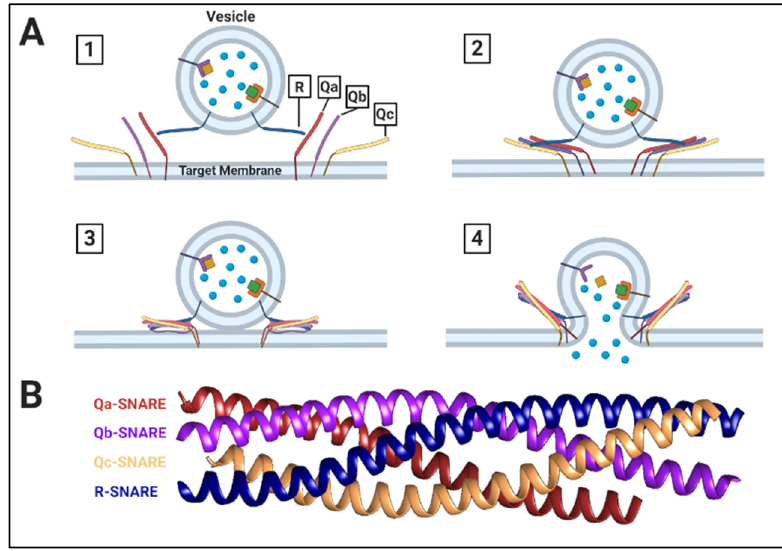
Figure 2. Overview of SNARE Function. ( A ) (1) Cargo-carrying vesicle with R-SNARE reaches the target membrane, which contains associated Q-SNAREs (not pictured: Rab proteins and other associated tethering factors). (2) The vesicle R-SNARE interacts with 3 target membrane Q-SNAREs to initiate SNAREpin complex formation. (3) The SNAREpin forms a “coiled-coil” quad complex, zippering the vesicle and target membrane bilayers into contact. (4) Membrane fusion occurs, releasing soluble cargo into the lumen of the target membrane. ( B ) Crystal structure of a Saccharomyces cerevisiae SNAREpin complex [31].